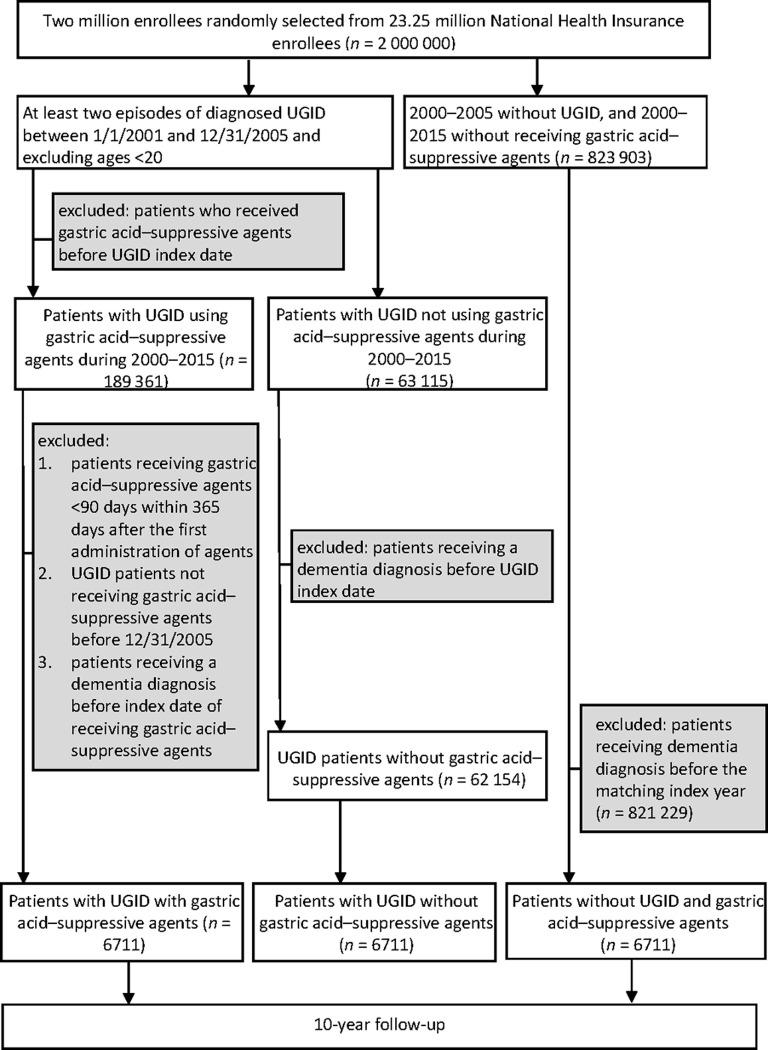
Flowchart of patient inclusion for analysis.